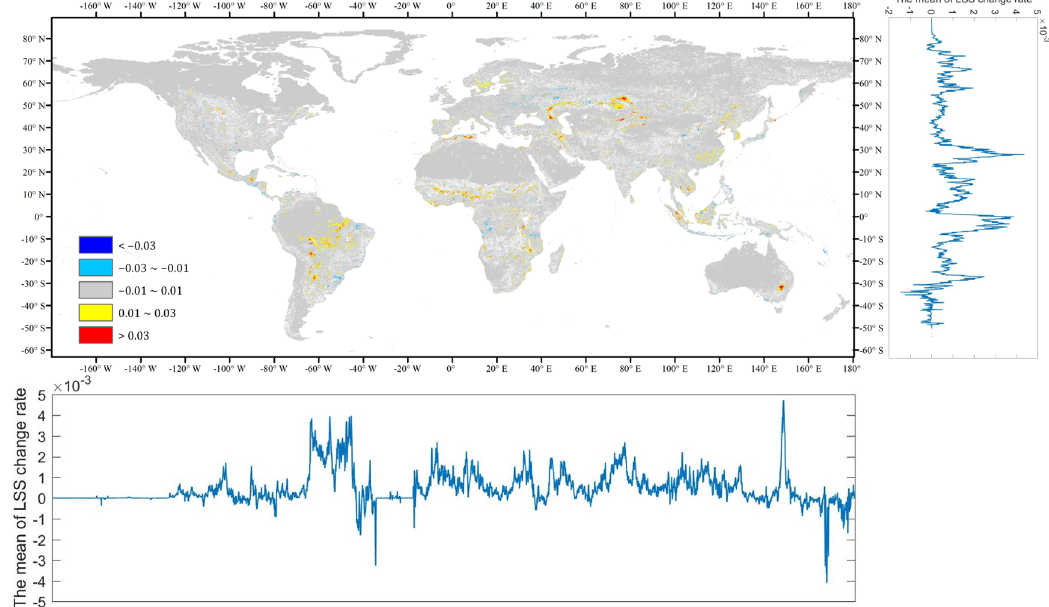
Figure 3. LSS change rate at a pixel scale from 1992 and 2018, and its means of the same longitude and the same latitude.